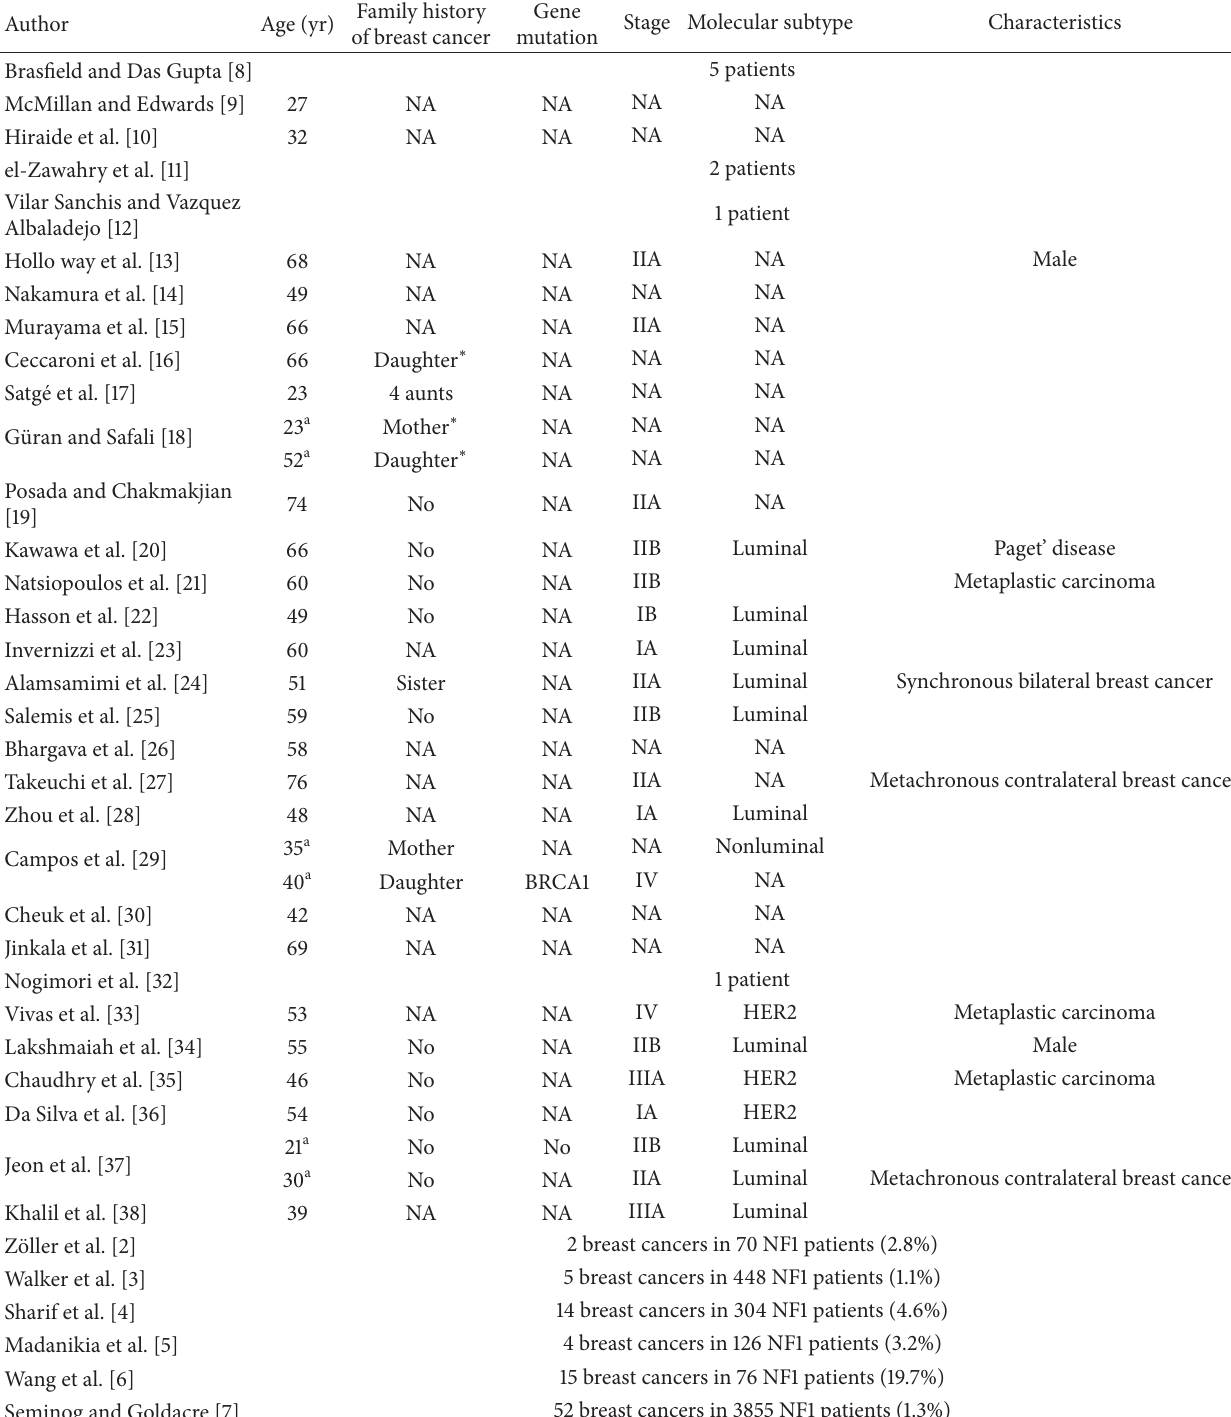
Table 1: Summary of previously reported NF1 patients with breast